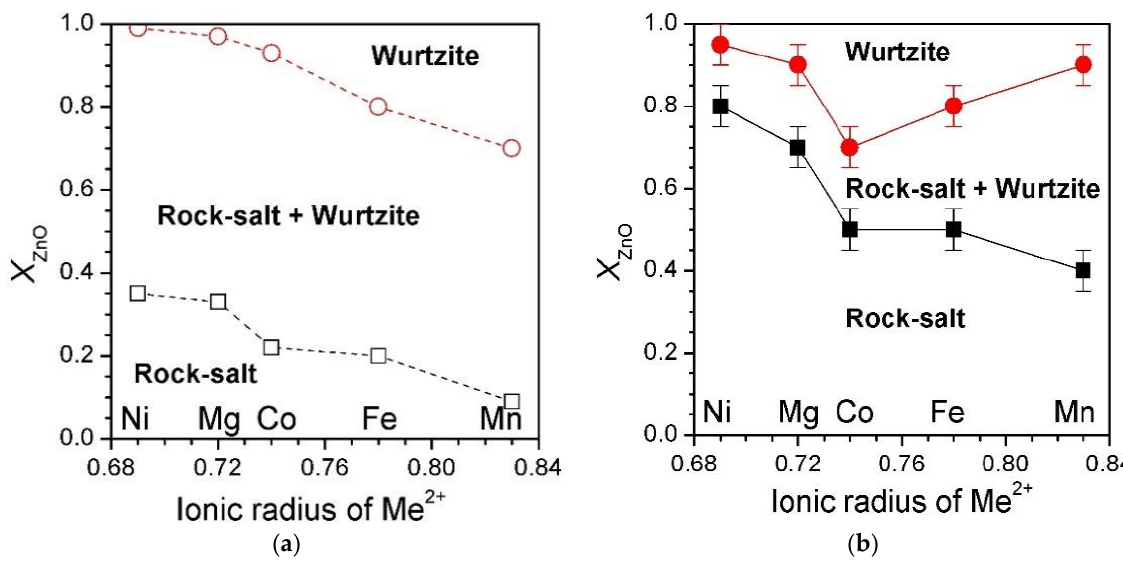
Figure 4. Phase composition in the ZnO-MeO systems as a function of the Me 2+ ionic radius: ( a ) at ambient pressure and 1100 K [7,46]; and ( b ) after quenching from 7.7 GPa and 1500 K [15,39,40]. Table 1. Phase composition of type I solid solutions with different ZnO/(MeO+ZnO) ratio after quenching from 7.7 GPa and 1450–1650 K